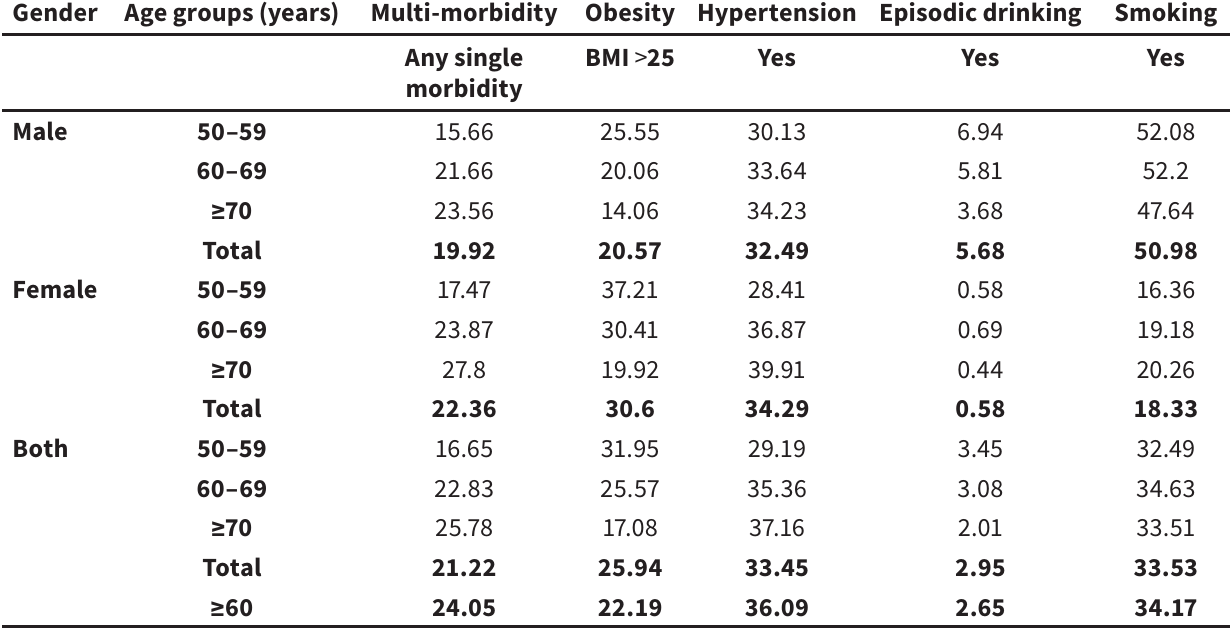
Morbidity and behavioral risk factors of the aging population in India (LASI-2017-18).